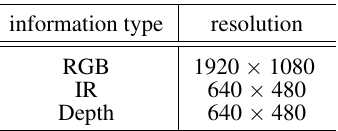
Table 1. Resolution of the outputs of the Pico Zense DCAM710